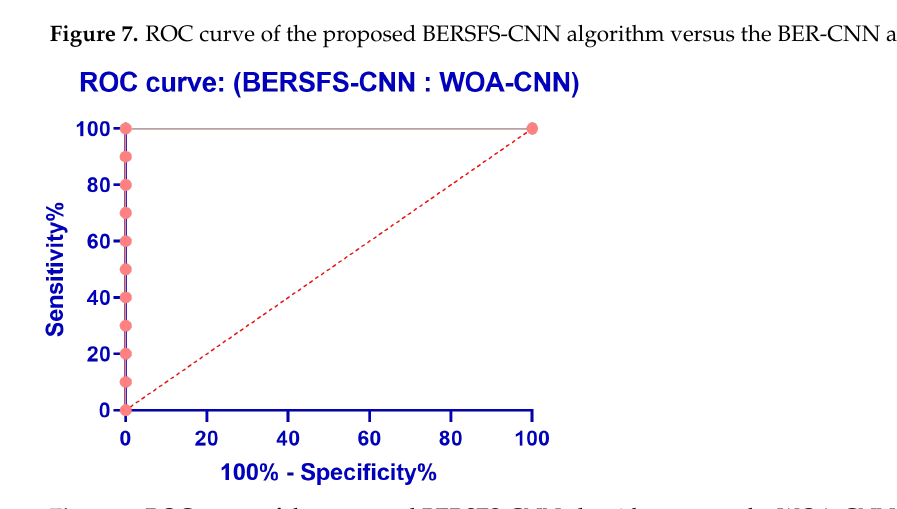
Figure 8. ROC curve of the proposed BERSFS-CNN algorithm versus the WOA-CNN